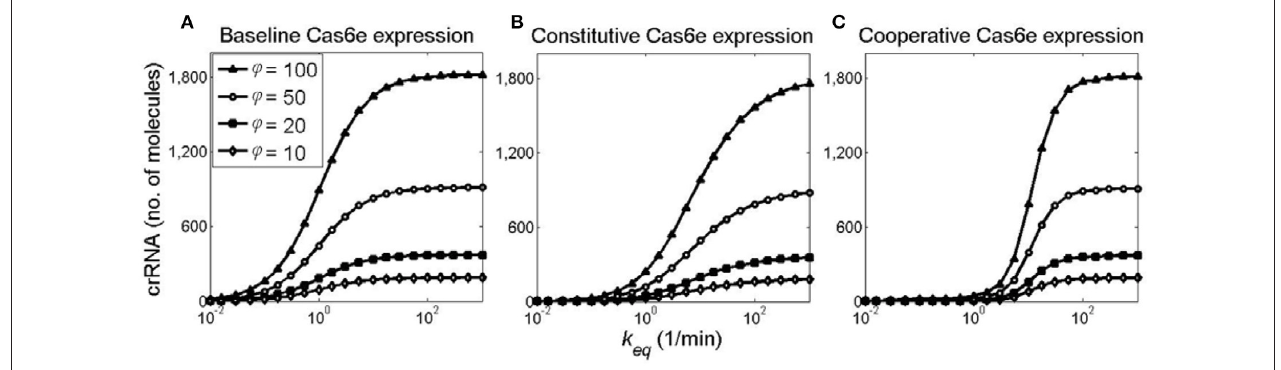
FIGURE 10 | Relieving saturation in generated crRNA amounts through joint k and ϕ increase. crRNA amount as a function of k eq at 20min post-induction, obtained for (A) baseline, (B) constitutive, and (C) cooperative models. Curves marked with diamonds, filled squares, circles, and filled triangles, correspond, respectively, to ϕ of 10, 20, 50, and 100